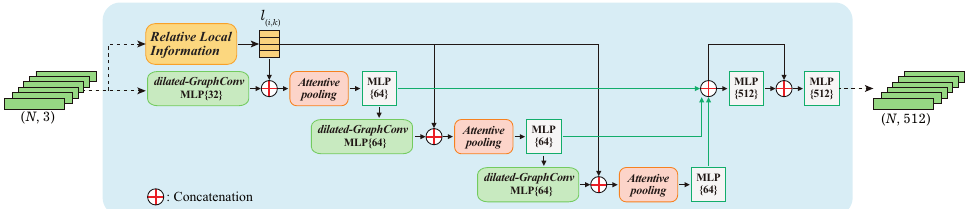
Figure 4. Feature extractor of FPCCv2 is built from a sequence of graph convolutions and MLPs. The high-dimensional (e.g., 512) features of each point are fed into the center score branch and the embedded feature branch of the original FPCC network,